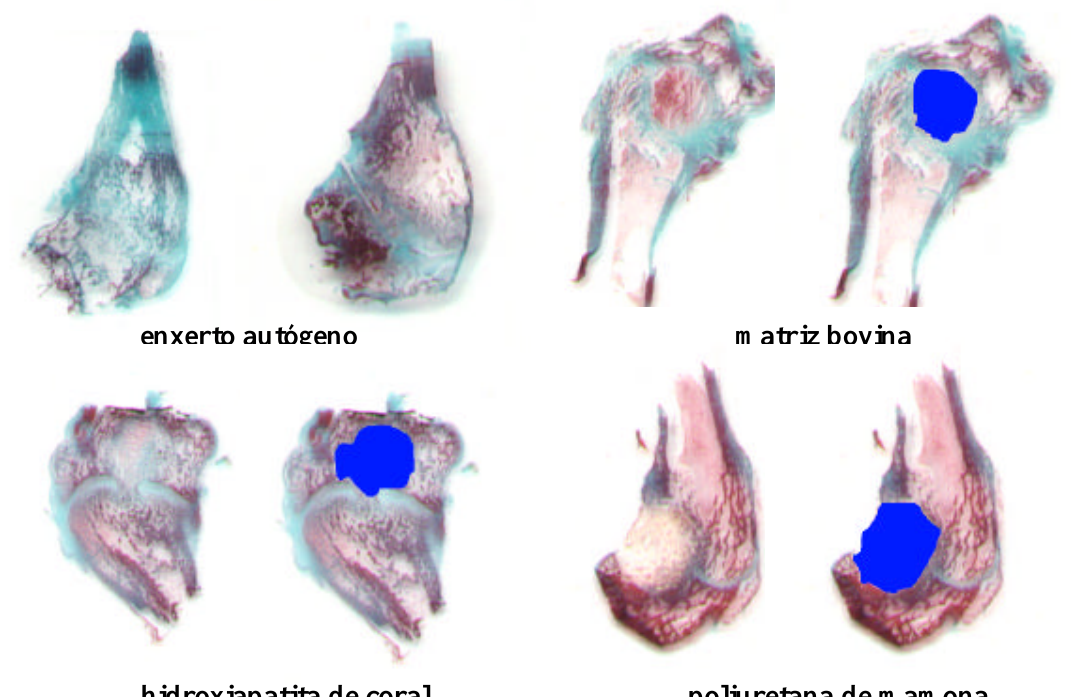
FIGURA 4 – Fotografia das imagens digitalizadas das lâminas histológicas dos côndilos femorais com seleção da área (em azul) ocupada pelos implantes nos diversos grupos de estudo, com seguimento de 12 semanas. No Grupo I não se visibilizou a área de transição entre o enxerto ósseo autógeno e o osso